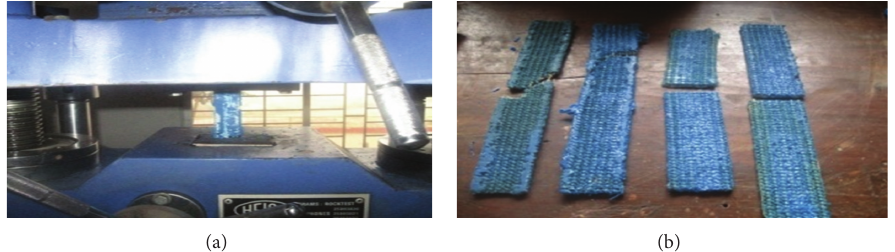
Figure 1: (a) Tensile testing; (b) tensile fracture samples of woven jute